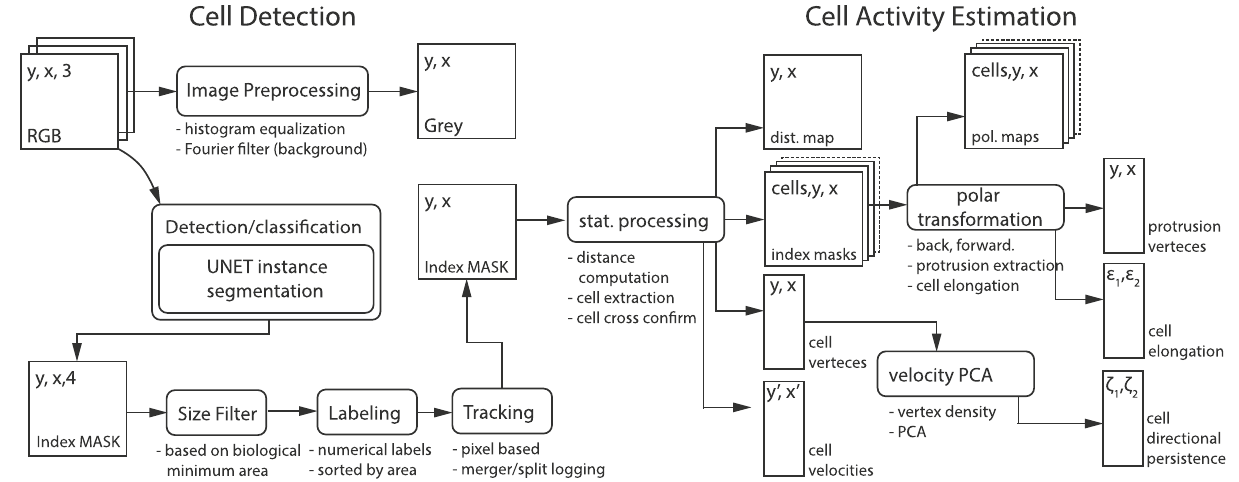
Figure 2. Image processing summary: cell detection (left-hand side) and cell activity estimation (right-hand side). The cell detection routine computes an index map that highlights cell and contaminant locations on a pixel-by-pixel base (semantic segmentation) from a gray-scale image. The cell activity estimation routine computes the various cell activity properties from a set of index